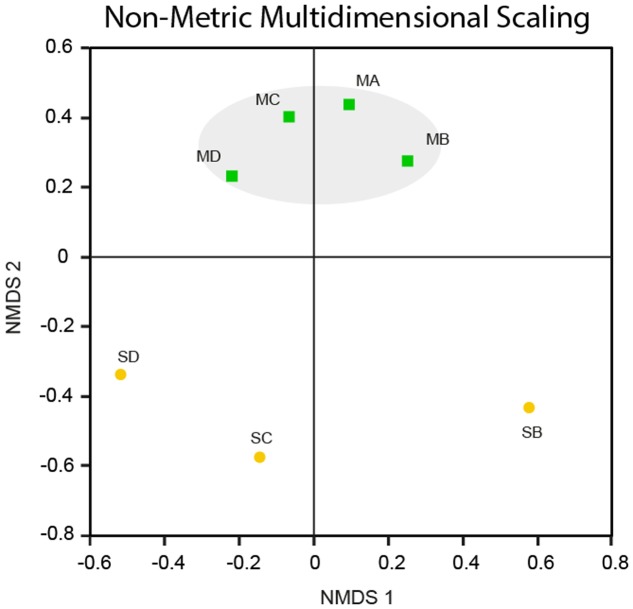
Non-metric Multidimensional Scaling. NMDS plot for Nullarbor meteorite (MA, MB, MC, MD) and soil (SB, SC SD) samples based on the Yue and Clayton (2005) community structure. The stress value is 0.146 [Stress values <0.2 indicate that an NMDS ordination plot has good spatial representation of differences between communities (Levshina, 2015)].